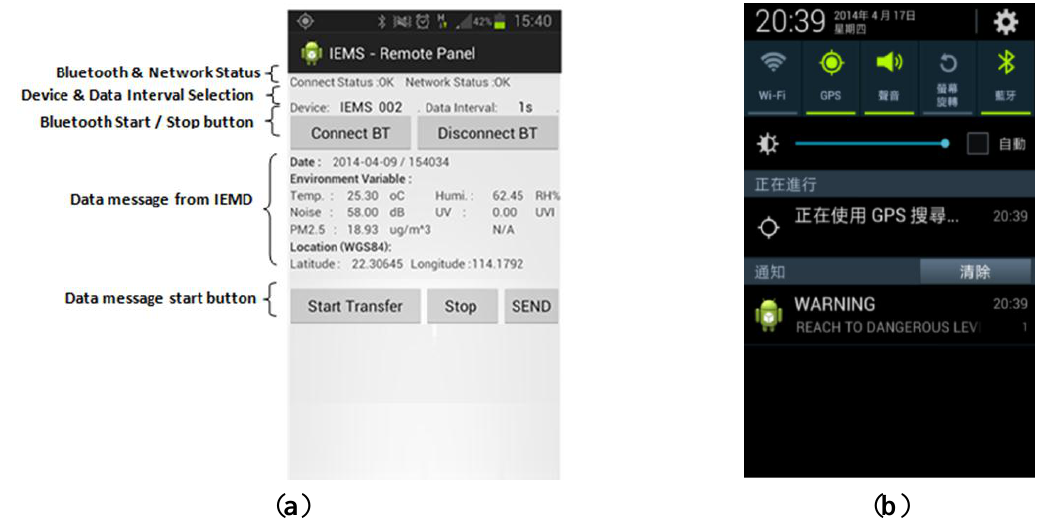
Figure 9. ( a ) User interface of RCP; ( b ) notification message in